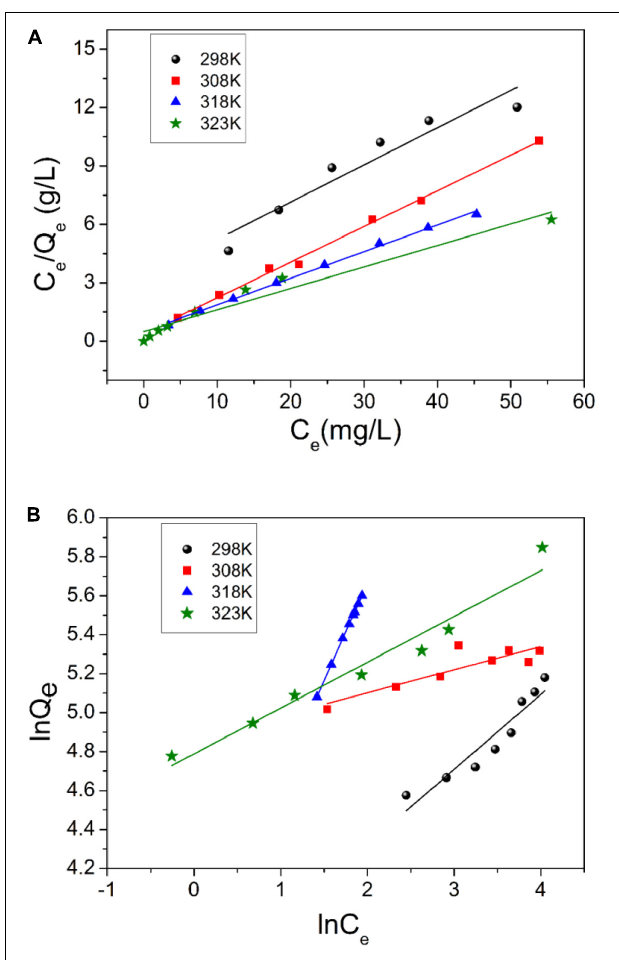
FIGURE 8 | Langmuir (A) and Freundlich (B) plot for the adsorption of uranium (VI) on TiO 2 /Ti (temperature 298–323 K, pH 5.0, amount of TiO 2 /Ti 0.025 g, and mixing time 60 min).